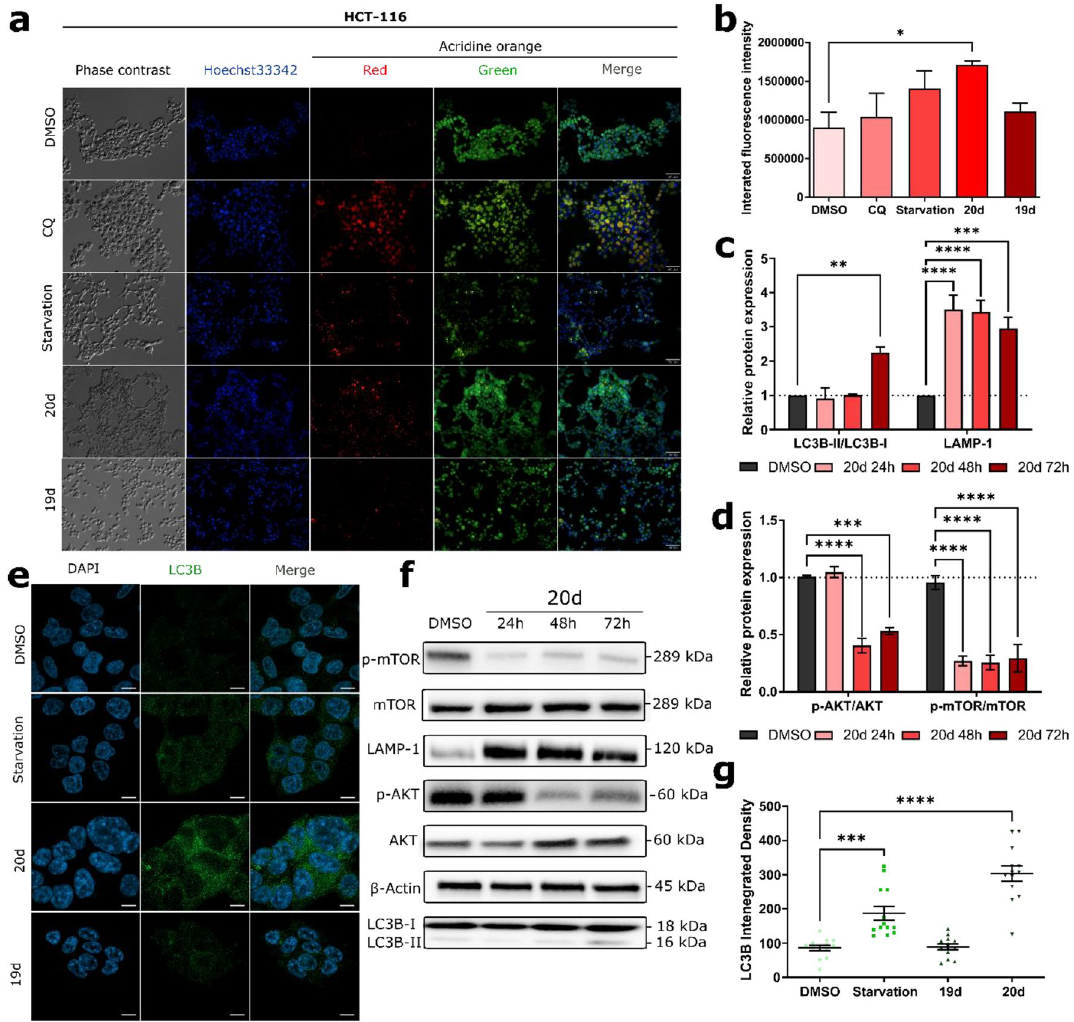
Figure 8. ( a ) Representative microscopic images of Hoechst33342- and AO-stained HCT-116 cells. Scale bar = 50 µm. Chloroquine was used as a reference. ( b ) Quantification of microscopic images, presenting the integrated red fluorescence intensity, depicted as mean ± SEM of data obtained from 10 random fields of view. ( c , d , f ) The expression of various proteins detected by Western blot assay after HCT-116 treatment with 20d or DMSO. The level of each protein was normalized to that of β-actin. Error bars represent the data ± SEM ( e ) Representative microscopic images of HCT-116 cells. LC3B is depicted in green and nucleus in blue (DAPI). Scale bar = 10 µm ( g ) Quantification of microscopic images showing the integrated density of LC3B presented as mean ± SEM of data obtained from 10 random fields of